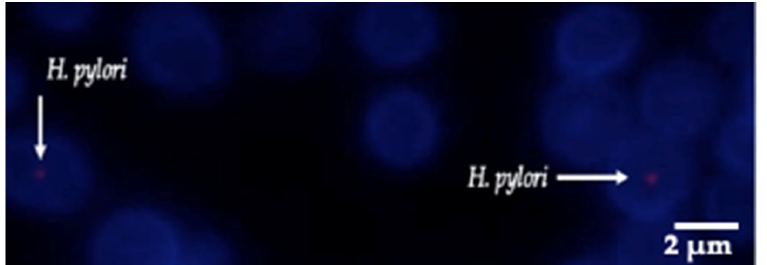
Figure 8. Yeast cells obtained from a H. pylori J99 ‐ C. glabrata LEO ‐ 37 co ‐ culture incubated under anaerobic conditions in Brucella broth medium plus 5% fetal bovine serum. The red fluorescence observed within yeast cells is a consequence of the hybridization of the H. pylori ‐ specific fluorescent probe (white arrow). Blue fluorescence corresponds to aniline blue bound to yeast 1,3 β‐ glucans.